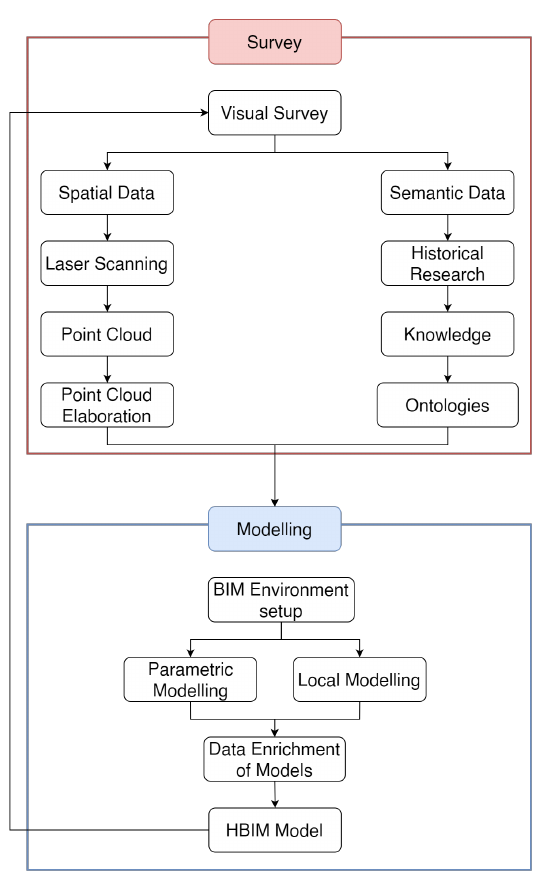
Figure 1 . Summary scheme of the proposed workflow.